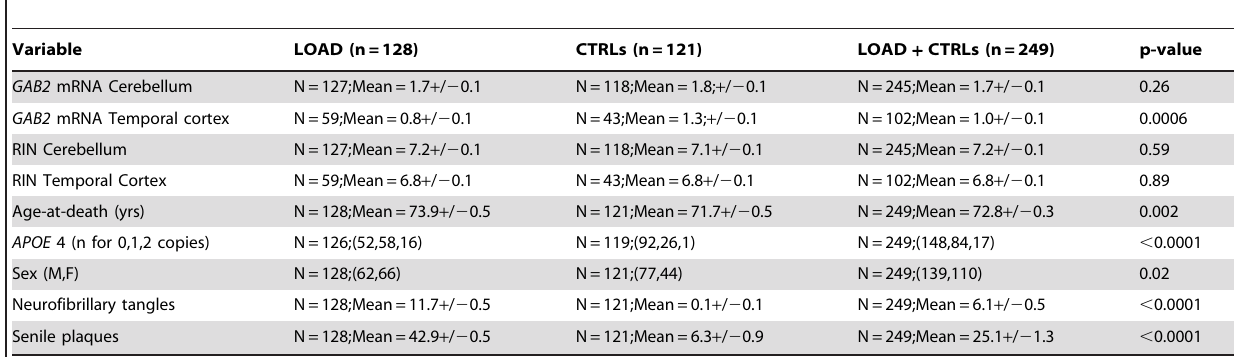
Table 8. GAB2 mRNA expression is increased in temporal cortex of control compared to LOAD brains.